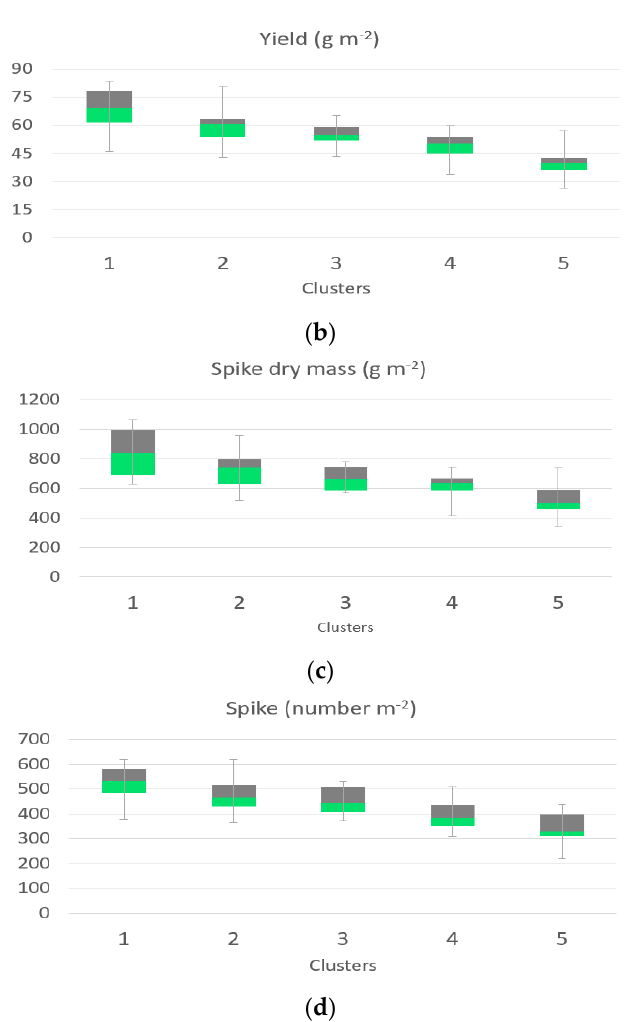
Figure 2. Box plot for different yield traits: Biomass ( a ), Yield ( b ), Spike weight ( c ), and Spike number ( d ) of the ten cultivars for the identified 5 clusters.